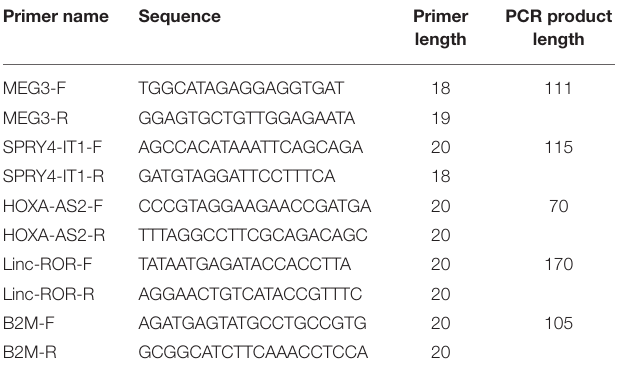
TABLE 1 | Detailed information of primers.